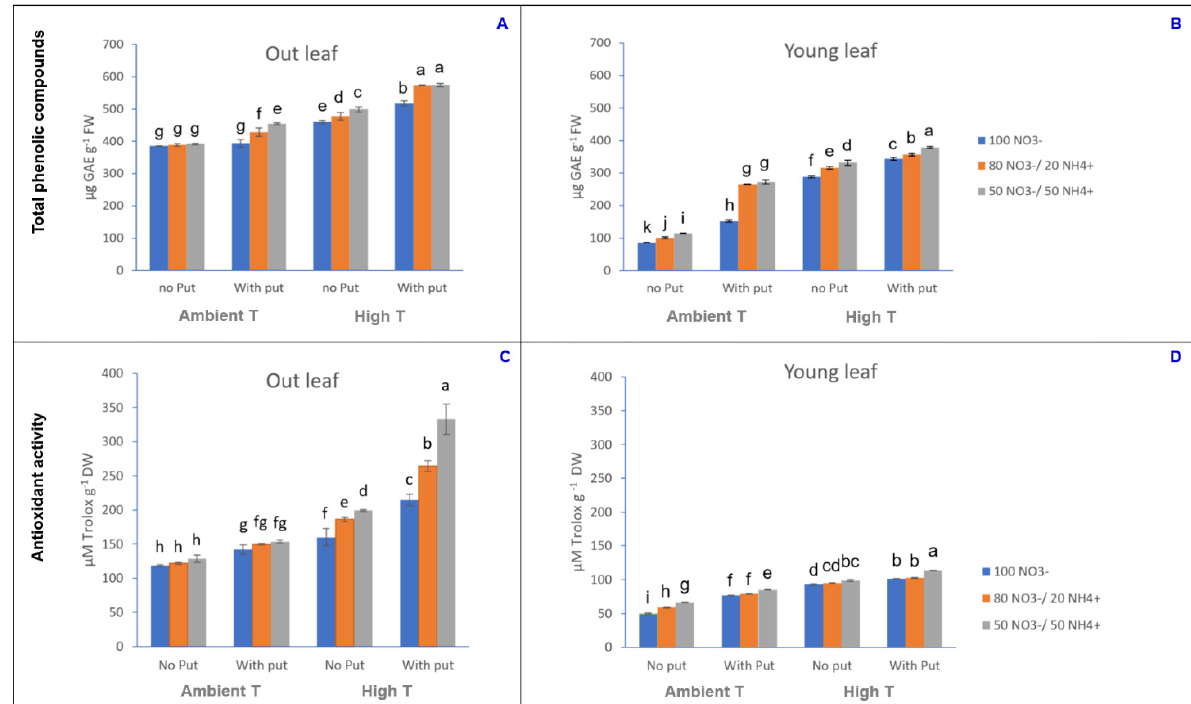
Figure 2. Total phenolic compounds in outer and young leaves ( A , B ), respectively and antioxidant activity in outer and young leaves ( C , D ), respectively of the cauliflower cv. Moonshine. For data analysis, an ANOVA was performed and the pairwise changes were defined using the Tukey post hoc test. Thus, different letters represent significantly different mean values according to the Tukey test at p ≤ 0.05.